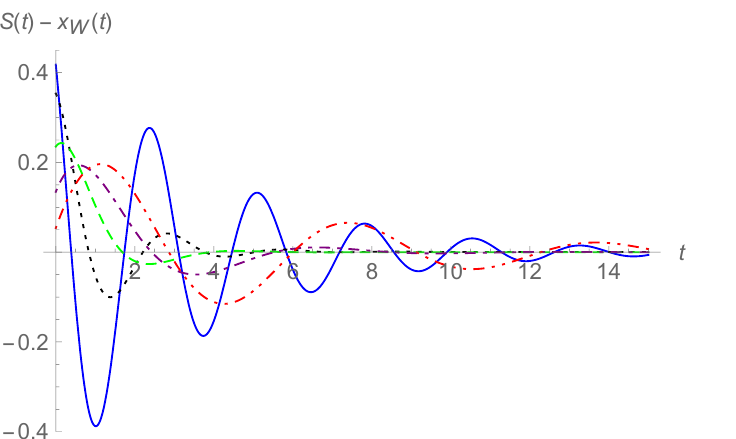
Figure 5. Response S ( t ) for α = 0.3 (solid line), α = 0.65 (dot line), α = 1 (dash line), α = 1.35 (dot–dash line), α = 1.7 (dot–dot–dash line).